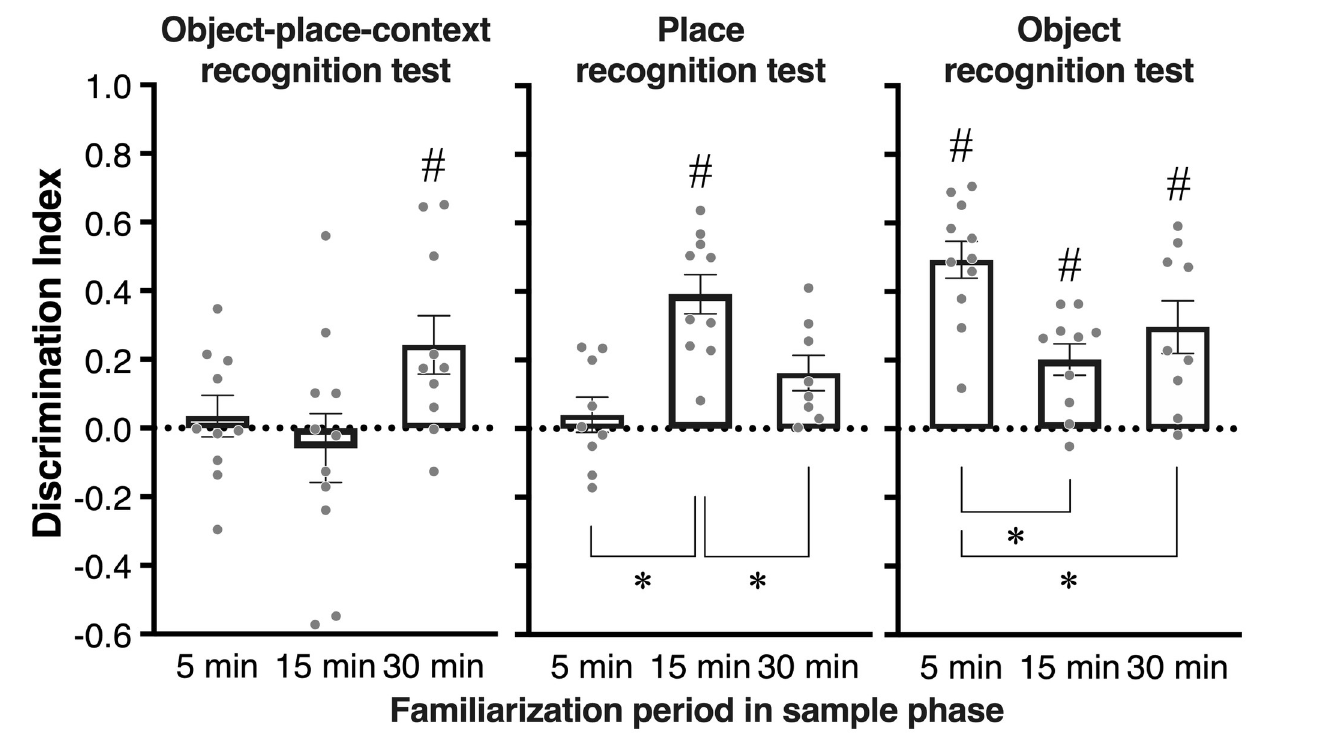
Fig 3. Mean ( ± SEM) discrimination index in test phase of OPC recognition test, place recognition test, and object recognition test. Each individual value is plotted as a gray dot. The horizontal dotted line indicates chance level (0). A one-way ANOVA followed by a post-hoc Scheffe test was used for comparison among each familiarization condition. � p < .05. # p < .05, † p < .10 compared to chance level using one-sample t test.